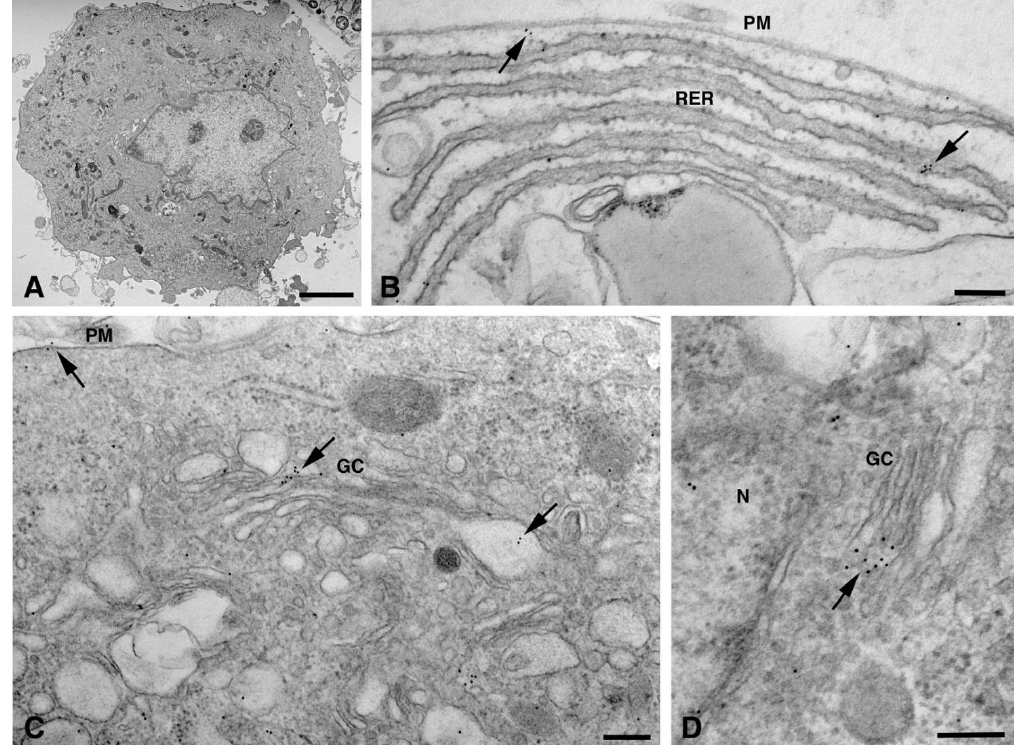
Figure 1. TEM immunogold analysis for Cx26 in dH9c2 cells. ( A ) Low magnification of representative cell counterstained with uranyl acetate and lead citrate without immunogold treatment. Scale bar 4µm. ( B – D ) Representative images of immunoreaction (arrows) at level of different cell compartments, rough endoplasmic reticulum (RER) and Golgi complexes (GC). Scale bars 200 nm . N, nucleus; PM, plasma membrane.